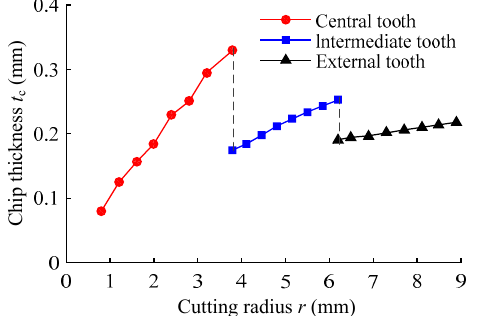
Figure 5. Distribution of chip thickness along cutting radius.